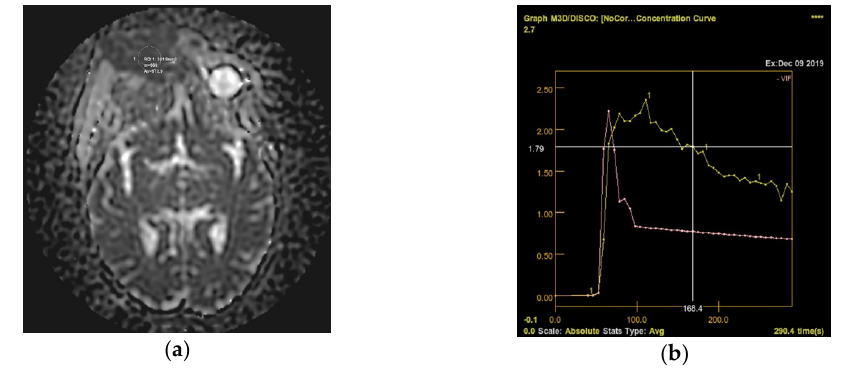
Figure 5. ( a , b ) The ax T2 PROPELLER sequence showing the necrotic areas in the primary lesion and secondary, satellite lesion in the superficial tissues of the frontal region (arrows).